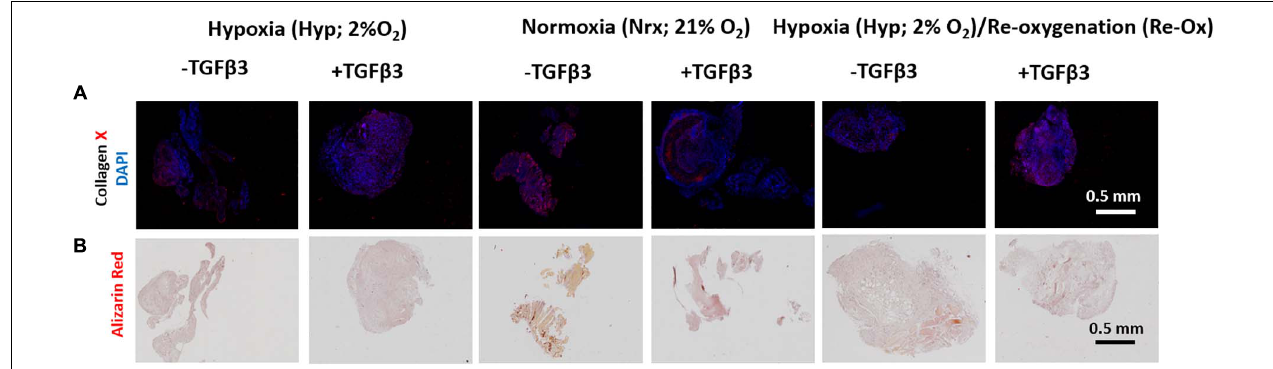
FIGURE 8 | Immunofluorescence (IF) and Alizarin Red S histochemical analysis of IFP-MSC pellets after 3 weeks of in vivo implantation in nude mice. (A) IF for collagen X and DAPI for cell nuclei; (B) Alizarin Red S staining for calcification. All immunostained and Alizarin Red S pellet sections were prepared at 5 µ m.